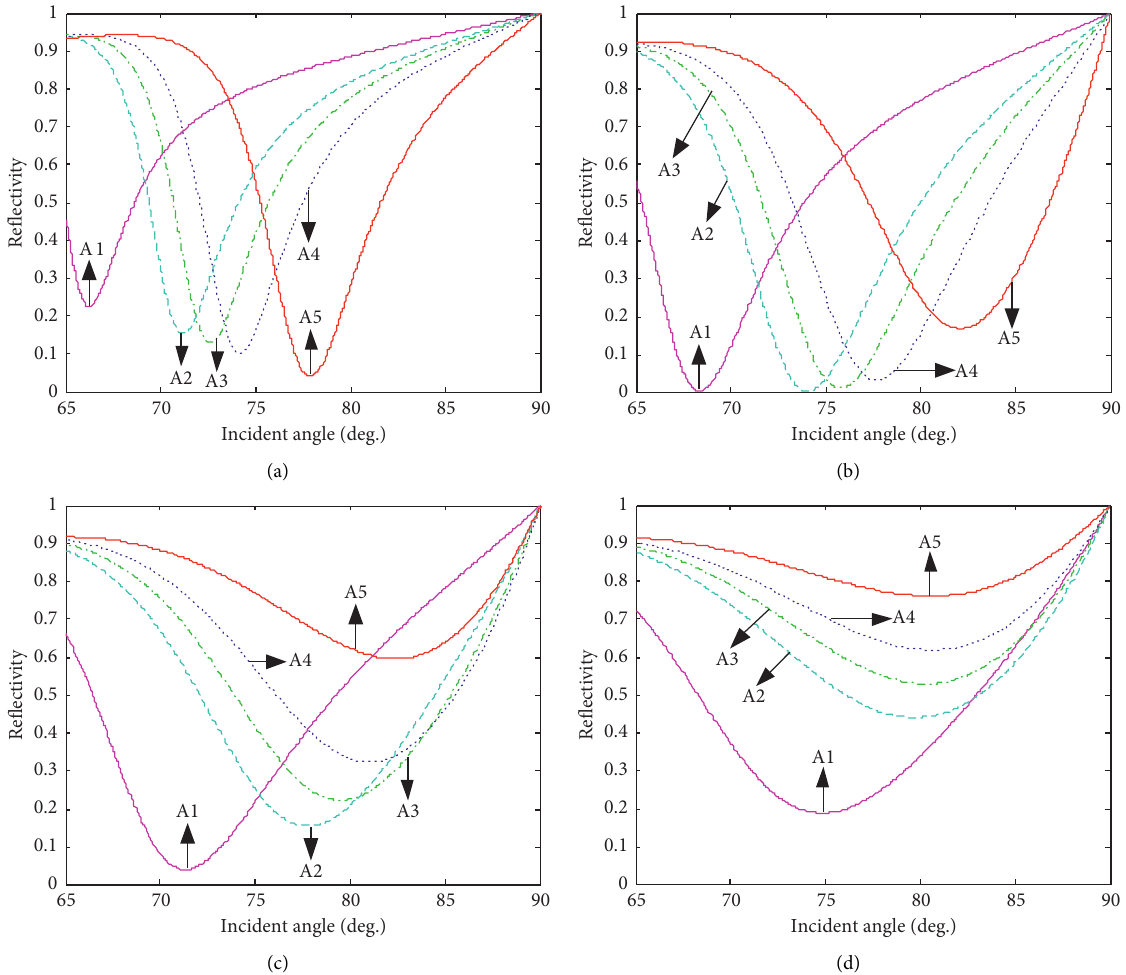
Figure 2: SPR spectrum (a) for number of MoS number of MoS 2 layer L � 3, for different refractive indices of sensing medium layer. The curves A1, A2, A3, A4, and A5 stand for the refractive index of sensing layers n � 1.30, n � 1.32, n � 1.34, n � 1.36, and n � 1.38, respectively. The thickness is 20nm, 10nm, 40 nm, and 1 × 1.6nm for TiO 2 , ZnO, Au, and GO layer,